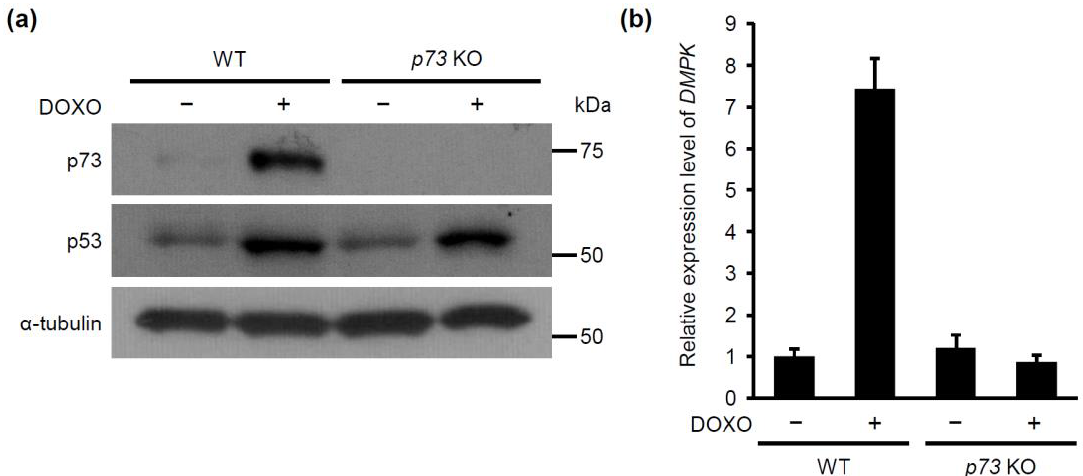
Figure 4. Knockout of p73 decreases DOXO-induced DMPK expression. MCF-7 cells were infected with control or p73 gRNA-expressing lentivirus using CRISPR/Cas9 system. ( a ) The cells were treated with DOXO (1.0 μ g/mL) for 16 h. Subsequently, cell lysates were subjected to immunoblot analysis with antibodies against p73, p53 , and α -tubulin as a loading control. ( b ) The cells were treated with DOXO for 24 h. Subsequently, DMPK expression level was evaluated using qRT-PCR. Each bar represents the mean ± SD; n = 3.